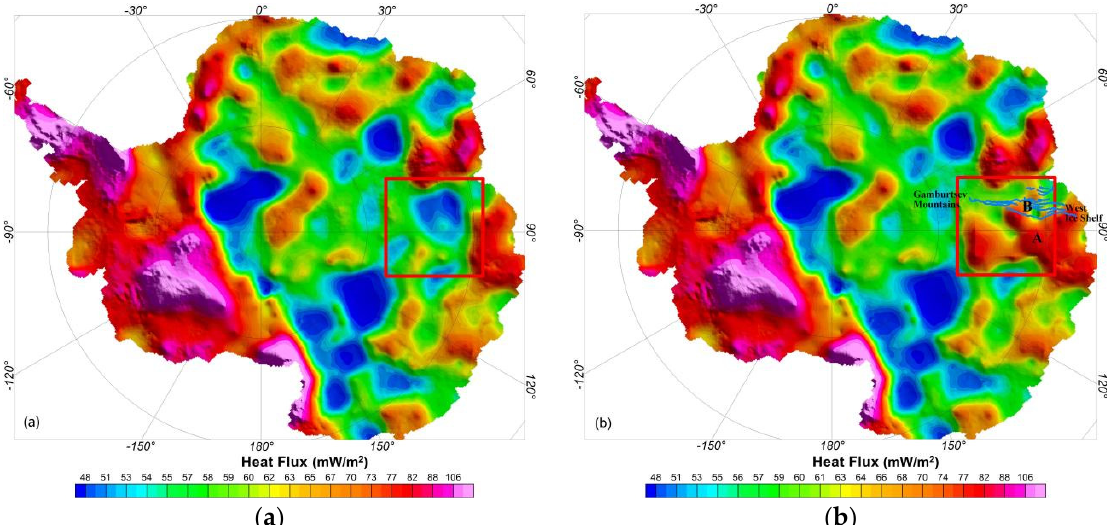
Figure 7. Comparison of heat flux maps. The ( a ) previous calculation results of all Antarctica [1], and ( b ) combining our calculation results in PEL (red frame area). Blue lines indicate the location of rifts.